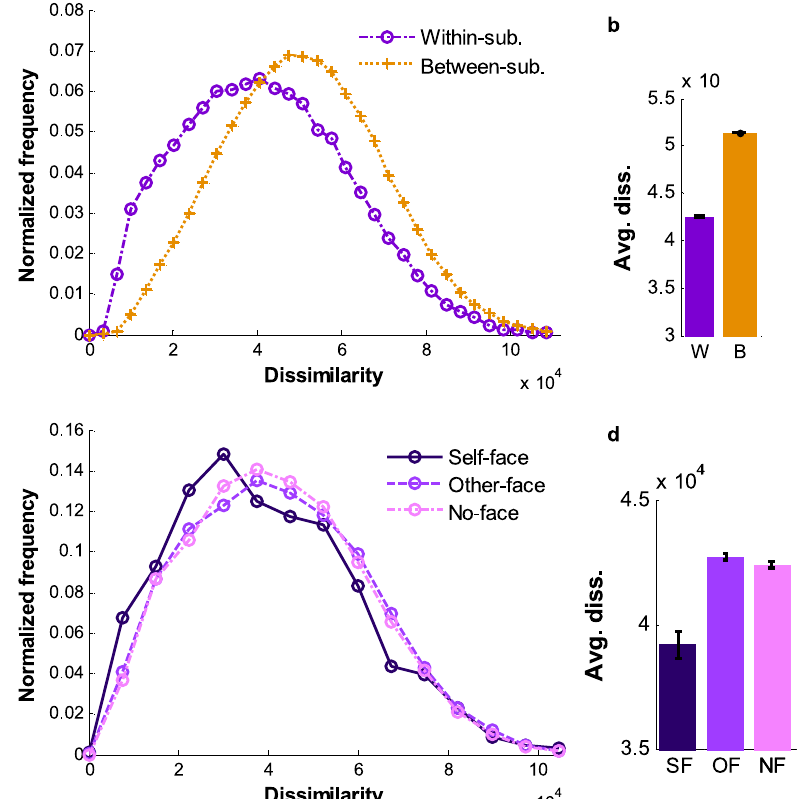
Figure 6. The frequency distributions of dissimilarity values between scanpath pairs with 1 Y interval. ( a ) The frequency distributions of within-subject ( n = 42,206) and between-subject scanpath pairs ( n = 551,851) plotted according to dissimilarity values. ( b ) The overall mean dissimilarity of each distribution in ( a ) (W: within-subject scanpath pairs, B: between-subject scanpath pairs). Similar to results from the original data, dissimilarity values from within-subject scanpath pairs are more distributed on the smaller values than those from between-subject pairs (Cohen’s d = 0.45). KL divergence from the distribution of between-subject scanpath dissimilarity values ( SP ) to that of within-subject ( SP ) is 0.12 (namely, = .  D (SP SP ) 0 12 ). ( c ) The frequency distributions of B W KL B W within-subject scanpath pairs plotted according to the dissimilarity values of each trial group ( n self-face = 1,216, n other-face = 22,278, and n no-face = 18,712). ( d ) The overall mean dissimilarity of each distribution in ( c ) (SF: self- face, OF: other-face, NF: no-face trial group). Within-subject dissimilarity values are smaller for the self-face trial group than those for the other-face (Cohen’s d = 0.16) and no-face trial groups (Cohen’s d = 0.15), and the differences in the distributions can be presented as = . . Although the values for effect size are not strongly supportive, the distributions from the other-face trial group and no-face are relatively similar to each other (Cohen’s d = 0.02 and ). The scanpaths of the 14 subjects who participated in the additional experiment were observed. The error bars in ( b ) and ( d ) represent standard